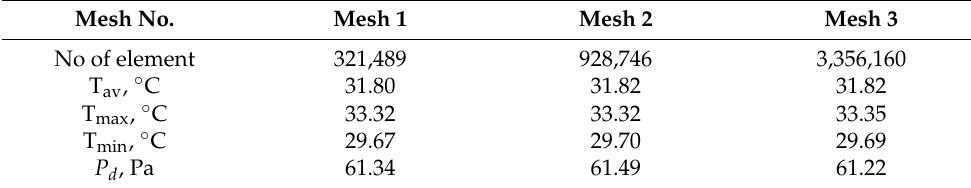
Table 4. Grid independency tests.